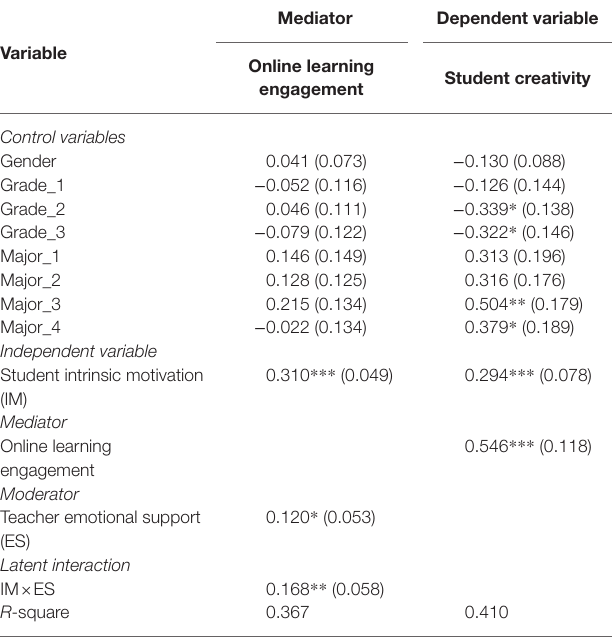
TABLE 5 | Results of the moderated mediation